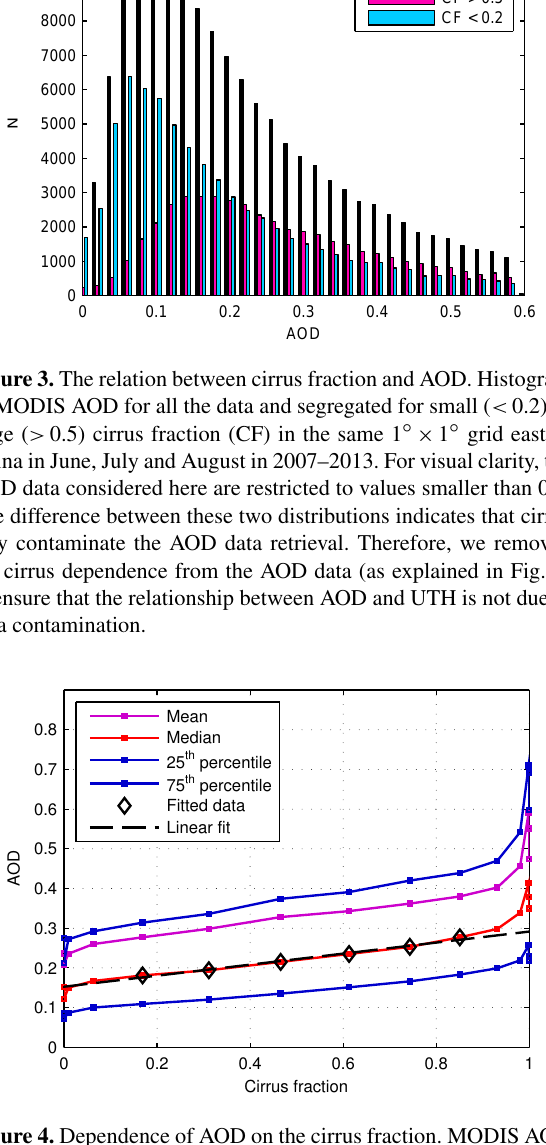
Figure 4. Dependence of AOD on the cirrus fraction. MODIS AOD at 550nm as a function of cirrus fraction (cf) in the same 1 ◦ × 1 ◦ grid east of China in June, July and August in 2007–2013. The dashed line shows a linear fit (AOD = 0.139 × cf + 0.153) obtained using the median data. In order to eliminate any possible AOD data contamination by cirrus, all AOD values for the cirrus fraction be- tween 0.1 and 0.9 were adjusted (AOD (cid:48) ) based on the following lin- ear fit: AOD (cid:48) = AOD − 0.139 × cf + 0.014. No correction was ap- plied to the data for the cirrus fraction smaller than 0.1, and the data with cirrus fraction larger than 0.9 were not used in this